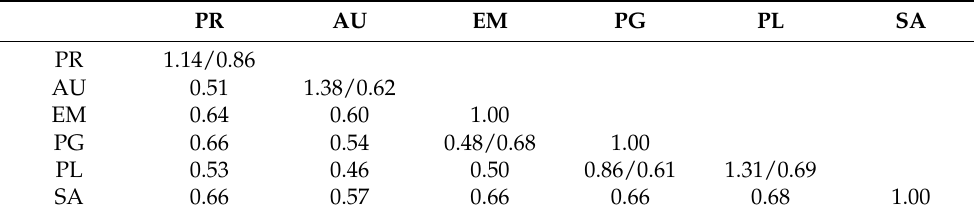
Table 4. Interfactor correlation of the six factors of PWB between women with and without breast cancer ( n =